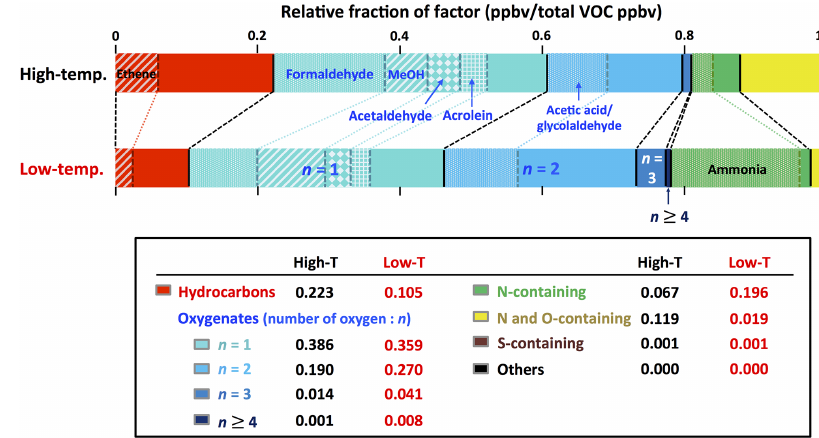
Figure 6. VOC composition in the high- and low-temperature emission profiles.